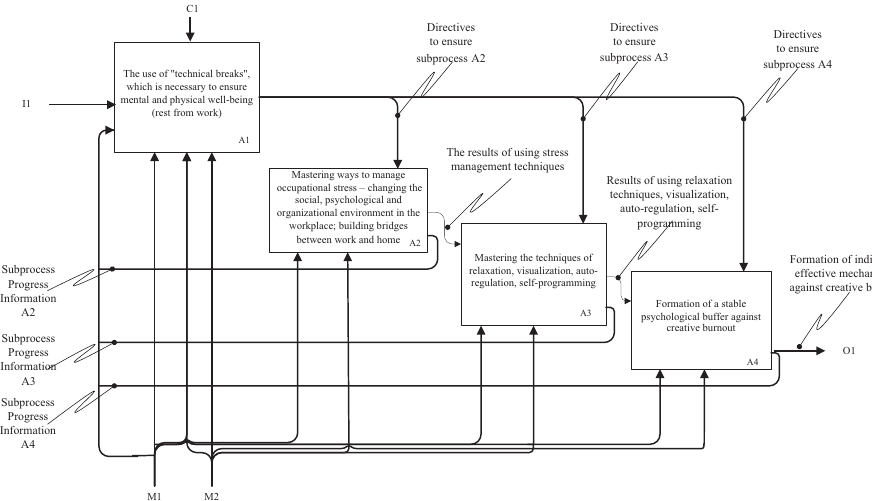
Figure 3. The decomposition of the first level of the context diagram of the functional model IDEF0 of reducing creative burnout (source: created by